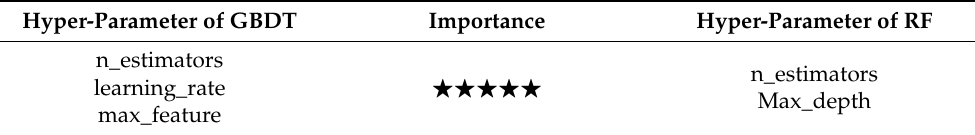
Table 2. The importance of different hyper-parameter in the RF model and GBDT